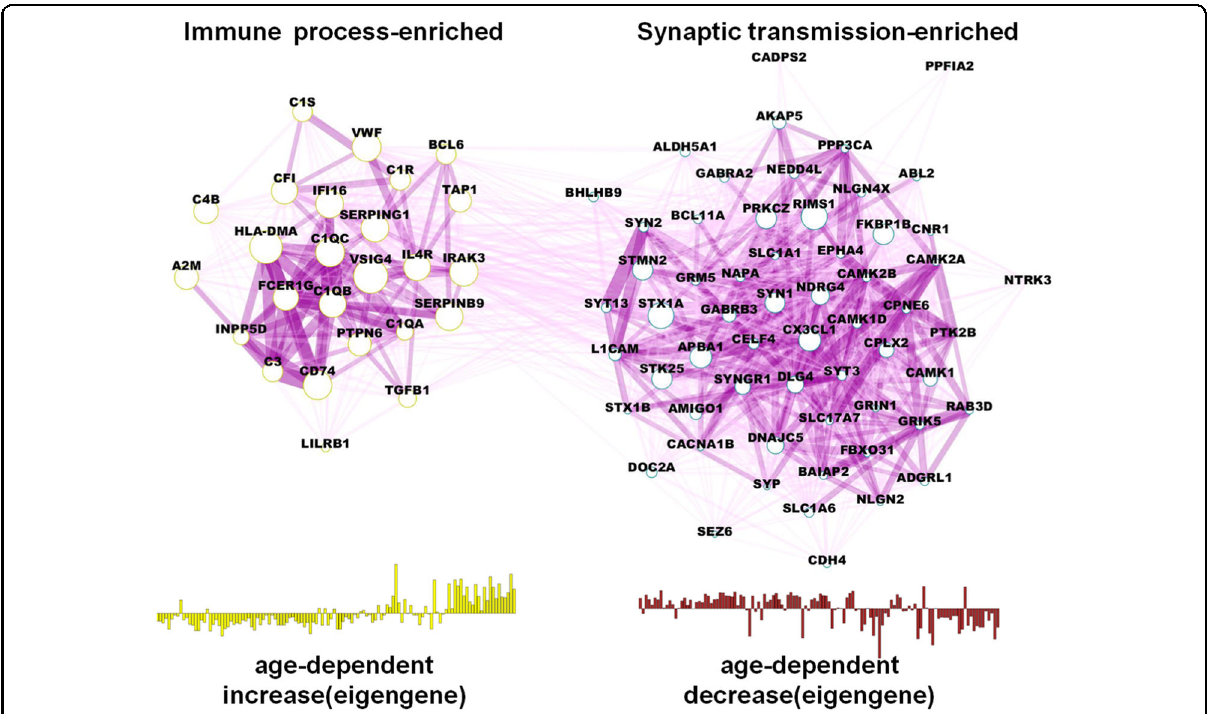
Fig. 4 Two co-expression modules in the aging hippocampus. Two representative sets of genes co-expressed with hippocampus aging and associated with immune process (left) and synaptic transmission (right). Two sets are anti-correlated in terms of gene expression. Widths of edges are proportional to the extent of expression